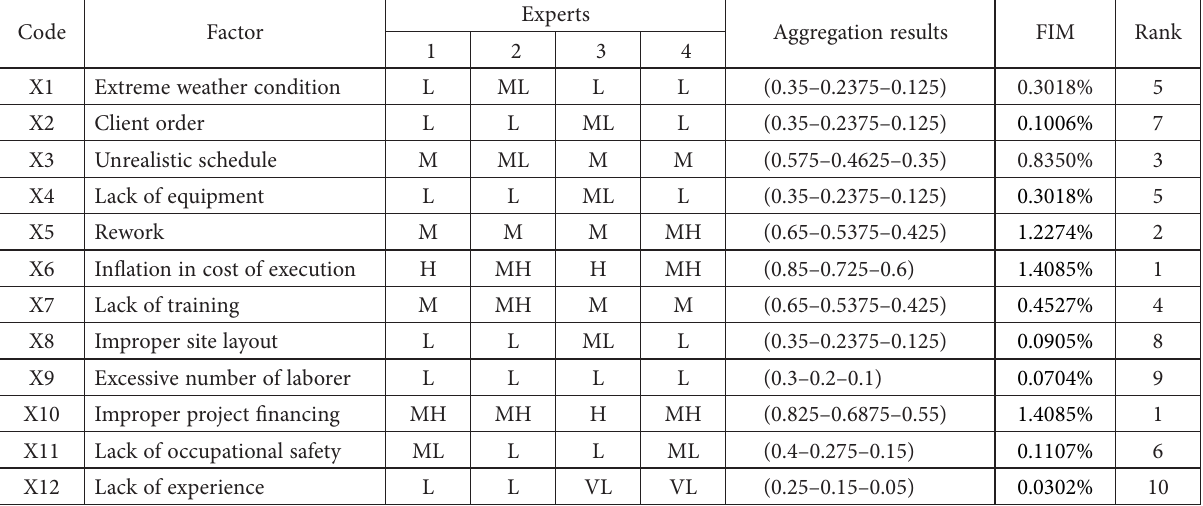
resultsExperts RankFIMAggregation 4 3 2